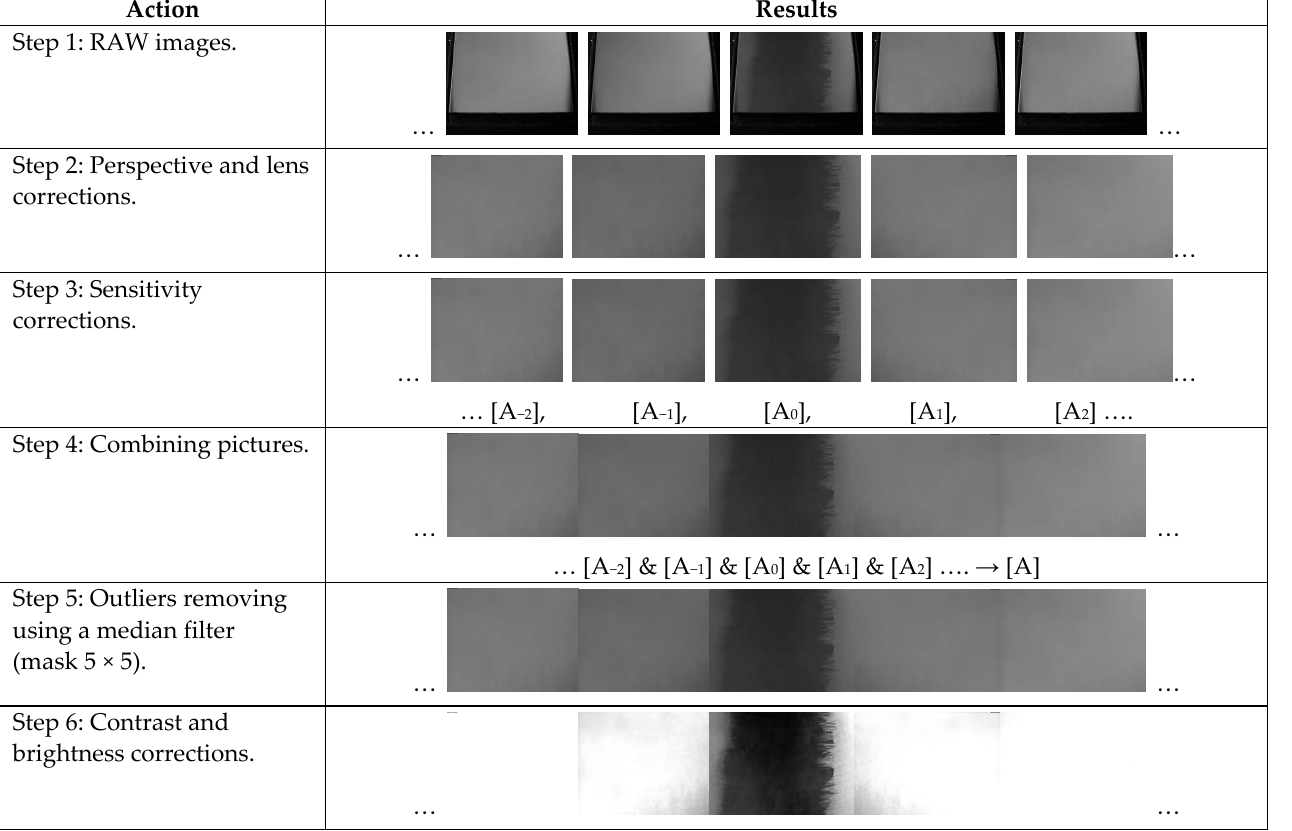
Figure 11. The processing of images obtained with the MO sensor; same pole magnetization (SPM); Sample S1; h = 0.5 mm.